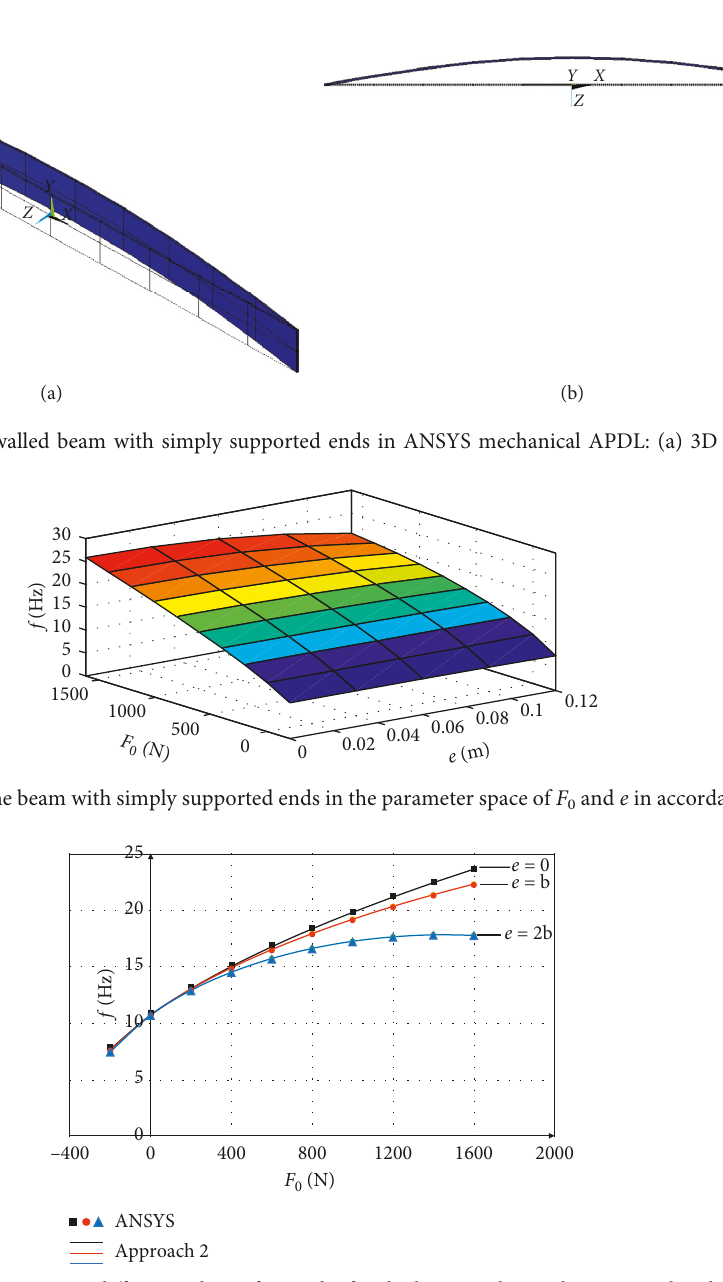
Figure 9: Natural frequency with respect to different values of F 0 and e for the beam with simply supported ends by ANSYS Mechanical APDL and Approach 2 (equation Table 2: Natural frequency f of the beam with simply supported ends by ANSYS mechanical APDL and Approach 2 (equation (29)). e 0 h 2 h F 0